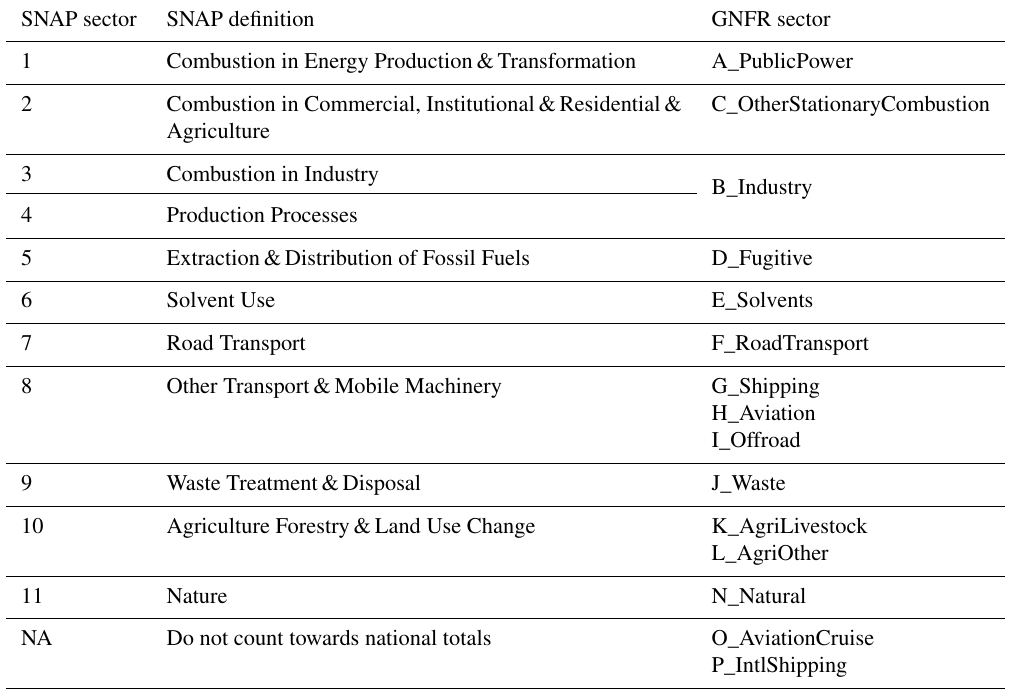
Table 1. Selected Nomenclature for sources of Air Pollution (SNAP) sectors for emissions inventory reporting as outlined by CORINAIR, alongside the Generalised/Gridded Nomenclature for Reporting (GNFR) sectors (broadly